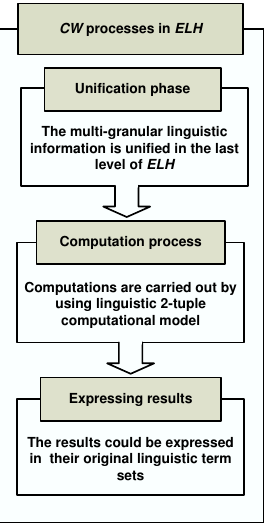
Fig. 3. Computing with words processes in